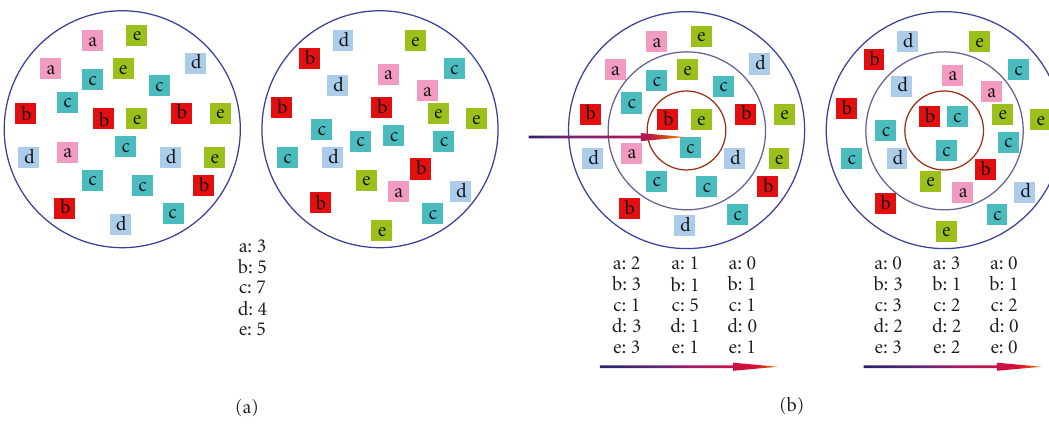
Figure 1: Comparing BWs and CBW representations. (a) Representing shapes with one global Bag-of-Words model. The left and the right shapes are both composed with 5 di ff erent words: a , b , c , d , e . Both feature vectors are [3,5,7,4,5], which count the occurrences of each word. That means using BWs representation, the left and the right shapes are regarded as the same. (b) Representing shapes with Concentric Bags-of-Words model. Even there are the same two shapes as shown in (a), because of the concentric sphere partitioning, the left and the right shapes are di ff erent. Along the arrow’s direction, counting from the outer sphere to the inner one, their feature vectors are [2 3 1 3 3; 1